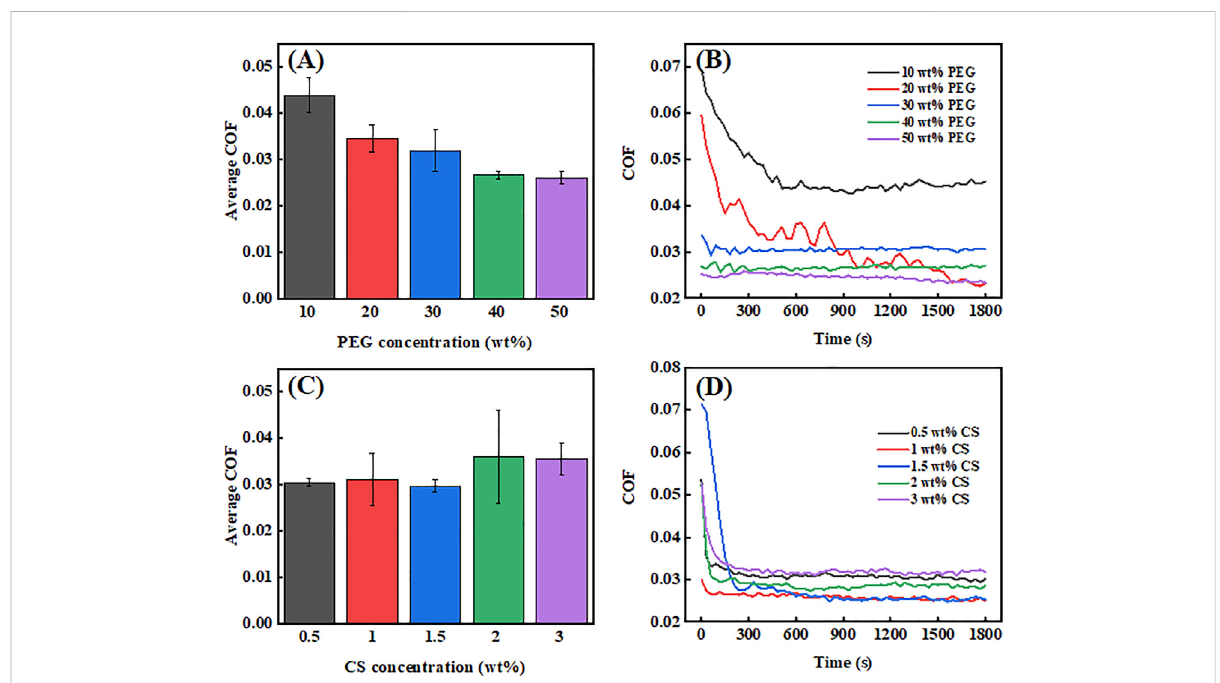
FIGURE 5 Average coef fi cient of friction (COF) values (A) and COF curves (B) of PEG at different concentrations. Average COF values (C) and COF curves (D) of CS at different